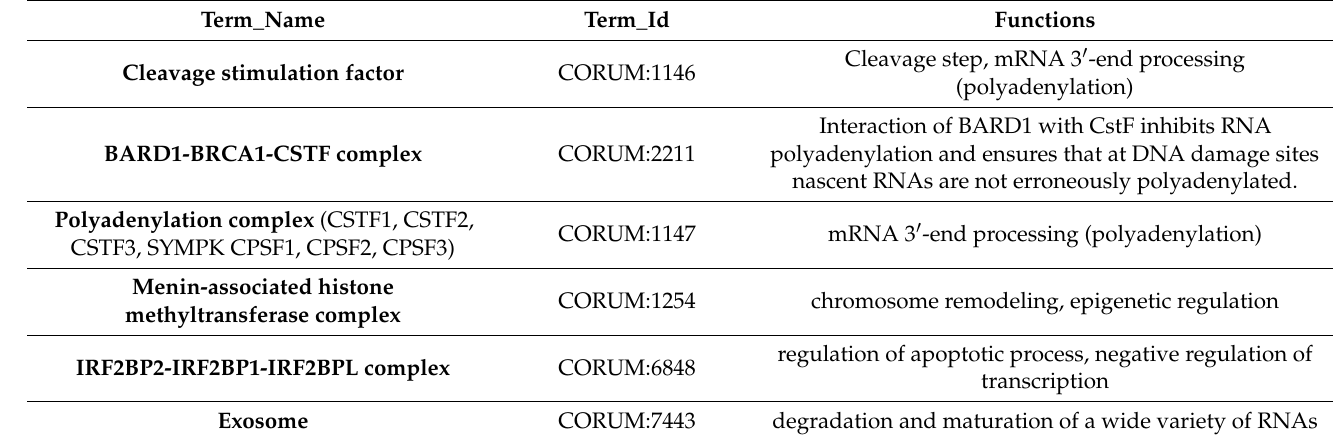
Table 1. Functions of menin-associated protein complexes enriched in CORUM database (https://mips.helmholtz-